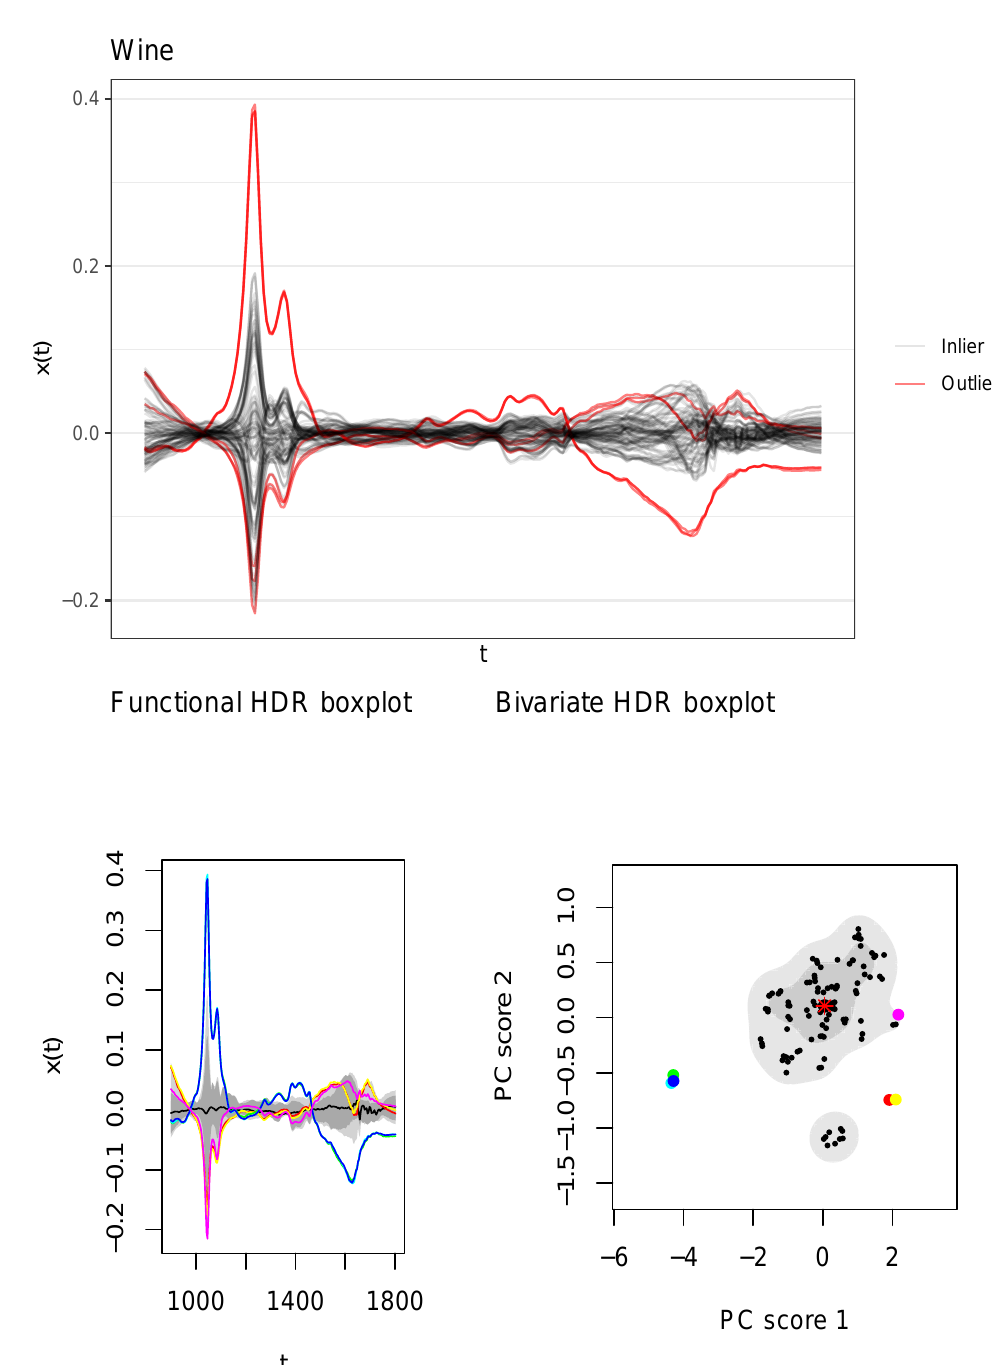
Figure A13. Upper row: Wine data. Lower row, left column: functional HDR boxplot; right column: bivariate HDR boxplot. Colored curves/points are outliers according a coverage probability of 0.05 for the functional HDR boxplot. HDR boxplots computed with rainbow::fboxplot